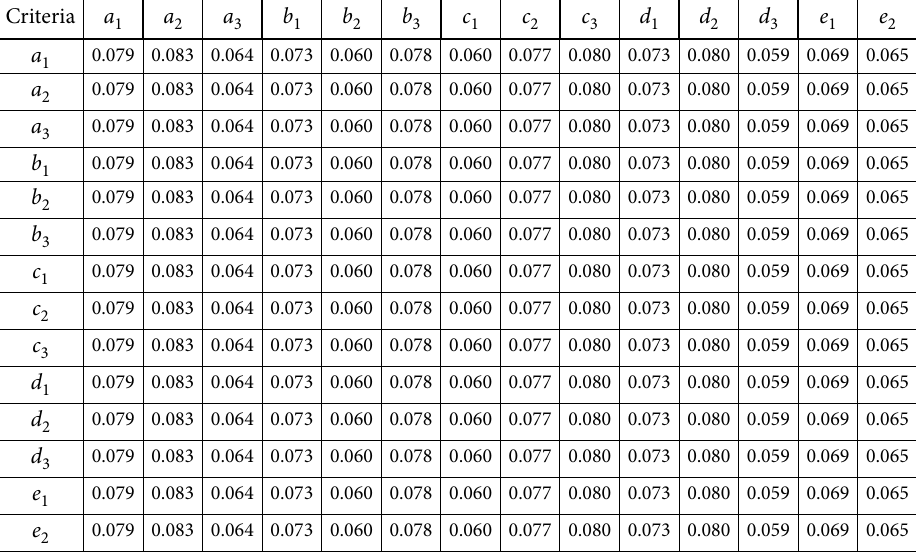
Table 6. D-ANP influential weights (Global weights) of system factors by lim ( ) W q →∞ h h .